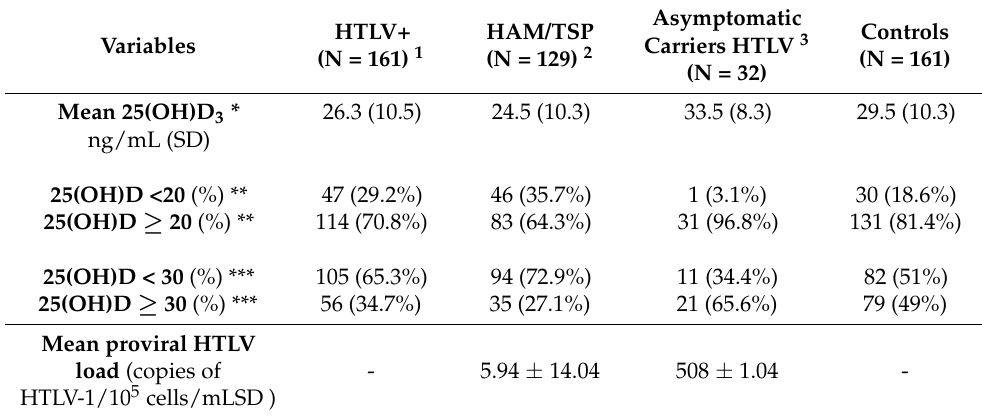
Table 2. Comparison between serum levels of vitamin D between the HAM/TSP, HTLV- asymptomatic carriers and controls